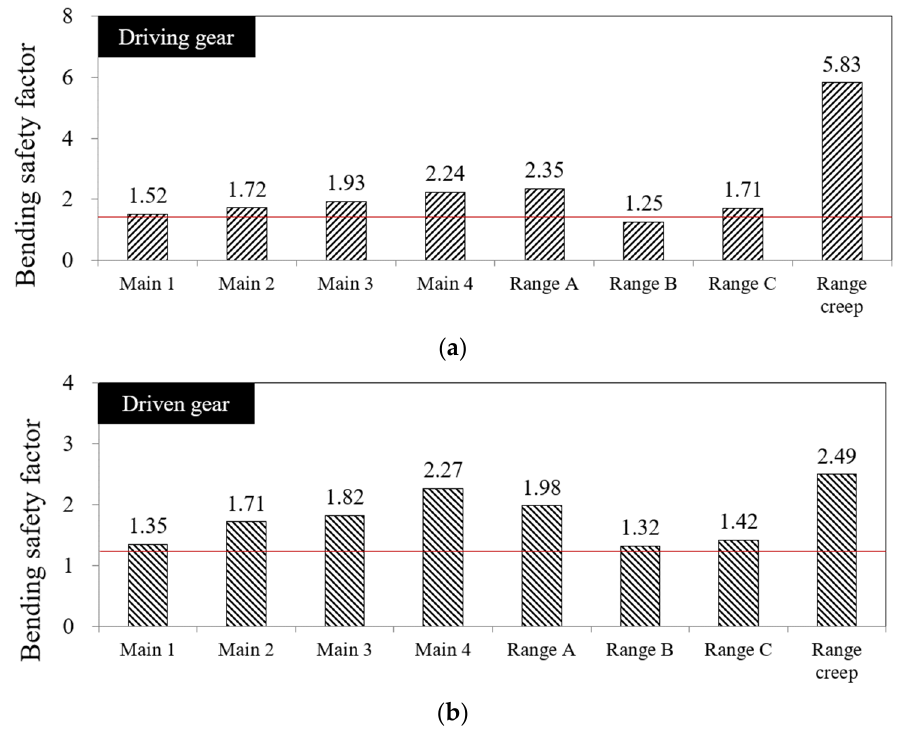
Figure 7. Results of bending safety factor for gears of the 86 kW class agricultural tractor transmission used in this study: ( a ) driving gears; ( b ) driven